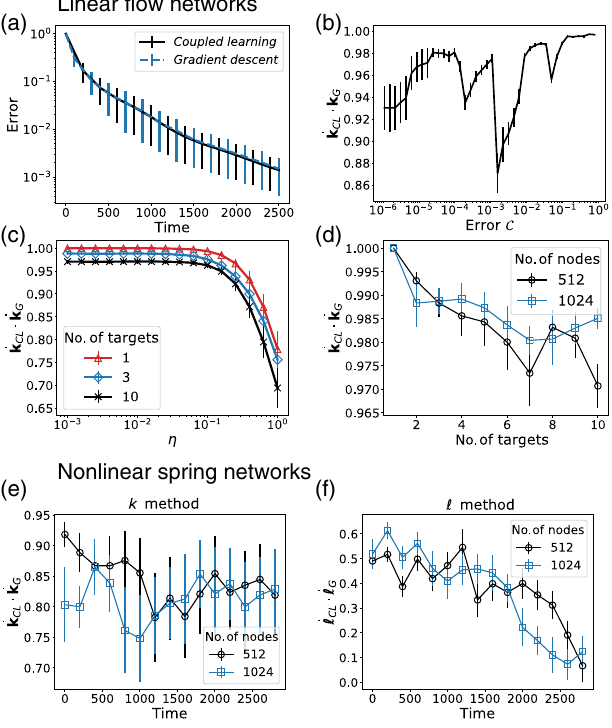
FIG. 7. Coupled learning (local supervised learning) compared to tuning (global supervised learning) in linear flow and nonlinear elastic networks. (a) Direct comparison between training traces in flow networks shows that coupled learning is as successful as gradient descent. (b) The dot product of the modification vector Δ k for coupled learning and tuning (gradient descent) during training undergoes fluctuations, yet remains high. (c) At the beginning of training, we compute the dot product of the modification vector Δ k for coupled learning and tuning as a function of the nudge variable η for systems with 1 (red triangles), 3 (blue diamonds), and 10 (black crosses) target nodes. The two methods predict very similar results for η ≪ 1 . (d) For η ¼ 10 − 3 , coupled learning yields similar results to tuning for networks with N ¼ 512 (black circles) and N ¼ 1024 (blue squares), as a function of the number of target nodes. (e),(f) Dot product between the normalized predictions of coupled learning and gradient descent in nonlinear elastic networks. We find that coupled learning and gradient descent are largely aligned during the training of elastic networks using the stiffness and rest lengths degrees of freedom ( N ¼ 512 , 1024, M S ¼ 10 , M T ¼ 3